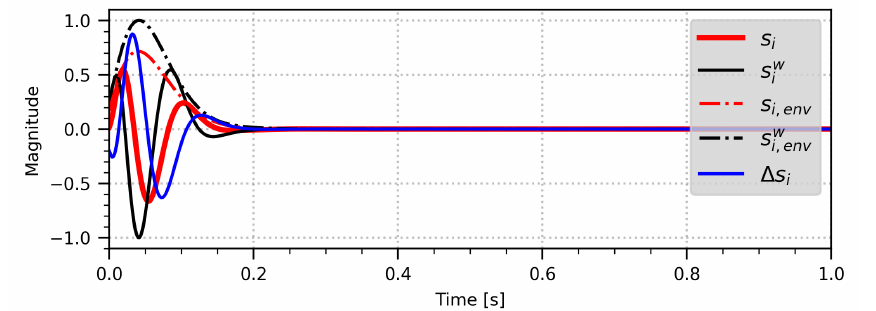
Figure 1. Comparison of the source wavelets and their envelopes. The solid-red and dash-dotted-red lines indicate the original minimum phase wavelet ( s i ) and its envelope ( s i , env ). The solid-black and dash-dotted-black lines indicate the wrong source wavelet ( s w The solid-blue line indicates the difference between the correct and wrong source wavelets ( ∆ s i ).